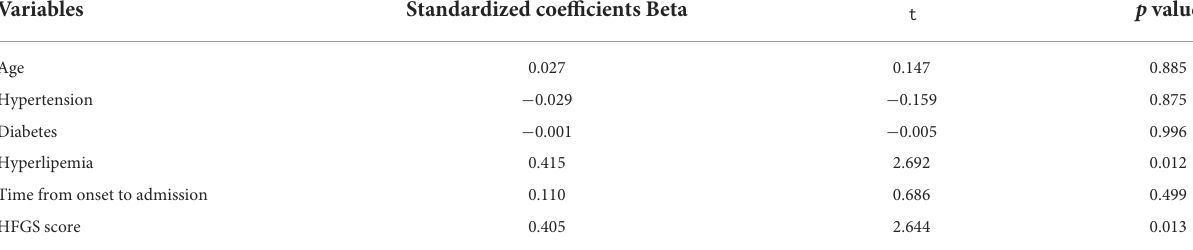
TABLE 2 The multiple linear regression analysis showing the correlation between MHR and HFGS score in patients with AIDP.